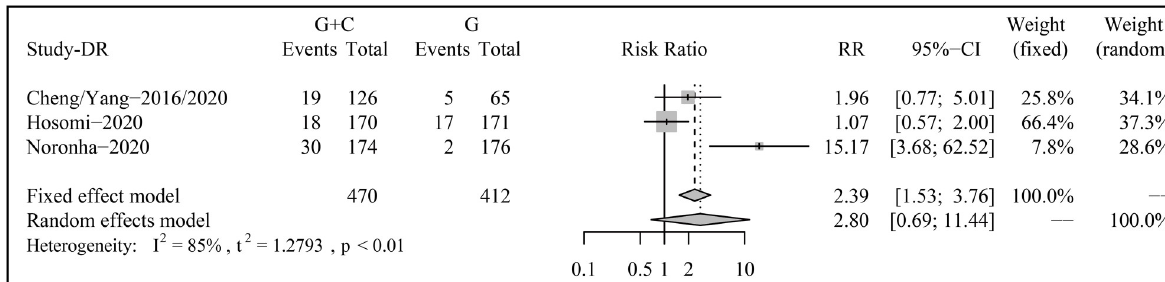
Fig 5. Forest plots of discontinuation rate (DR) for risk ratios